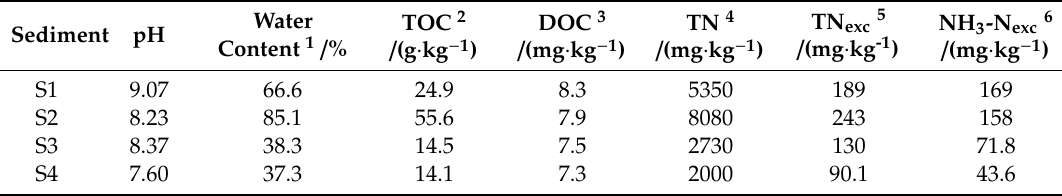
Table 3. Physicochemical properties of the four tested sediments.